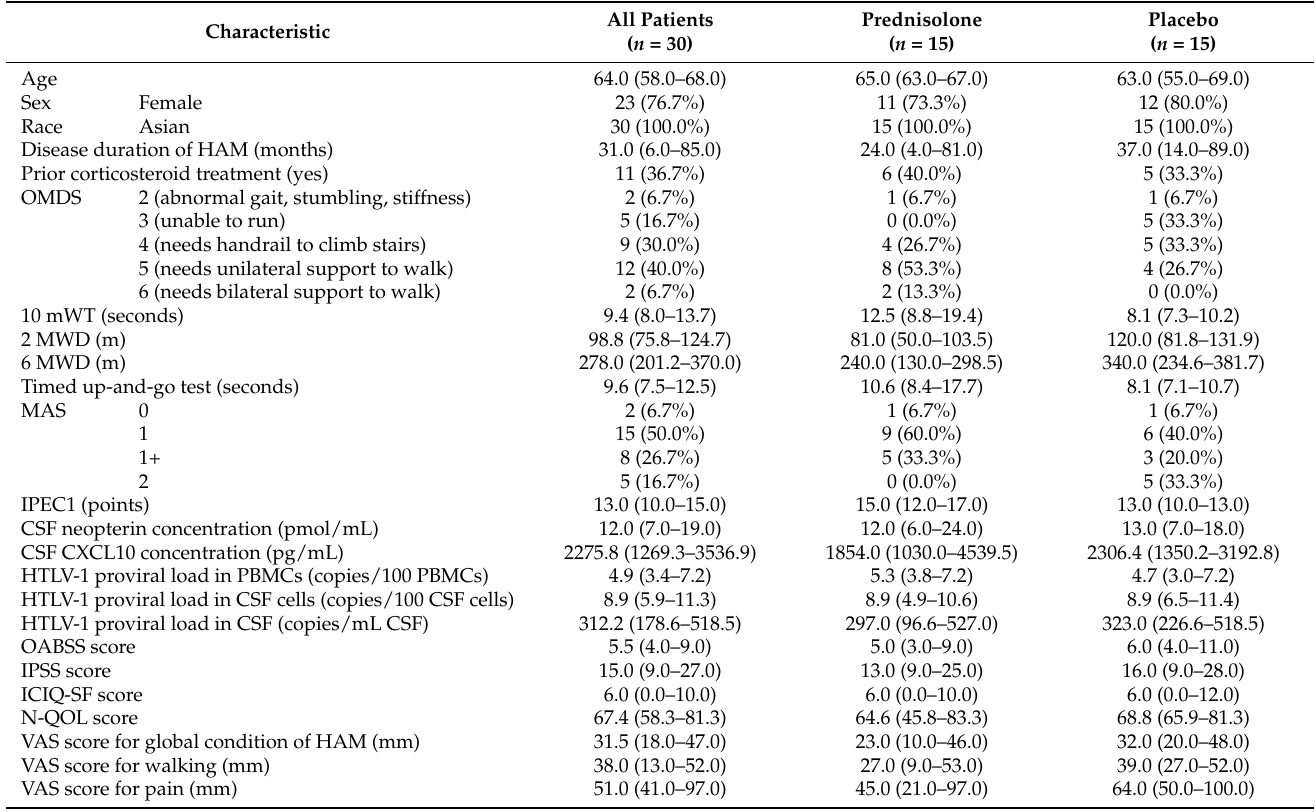
Table 2. Characteristics of slow progressors at baseline.